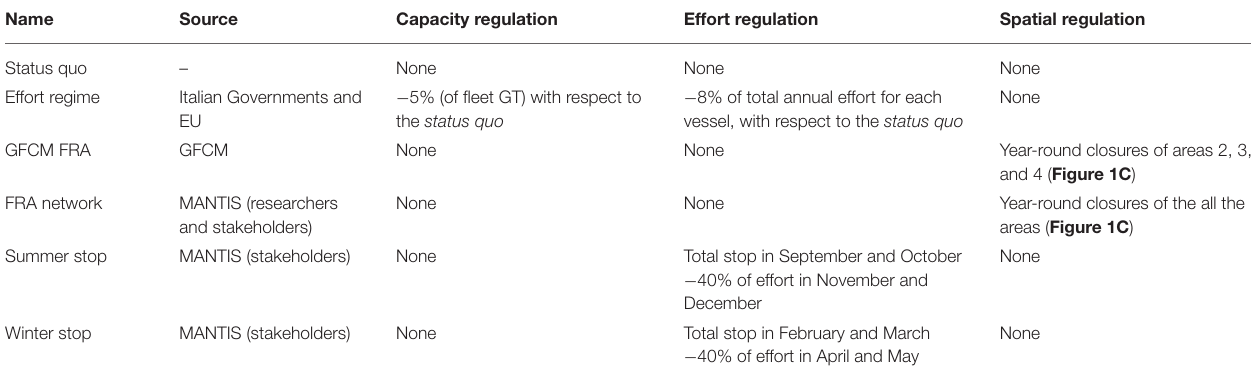
TABLE 4 | Summary of the different scenarios compared through a simulation approach.